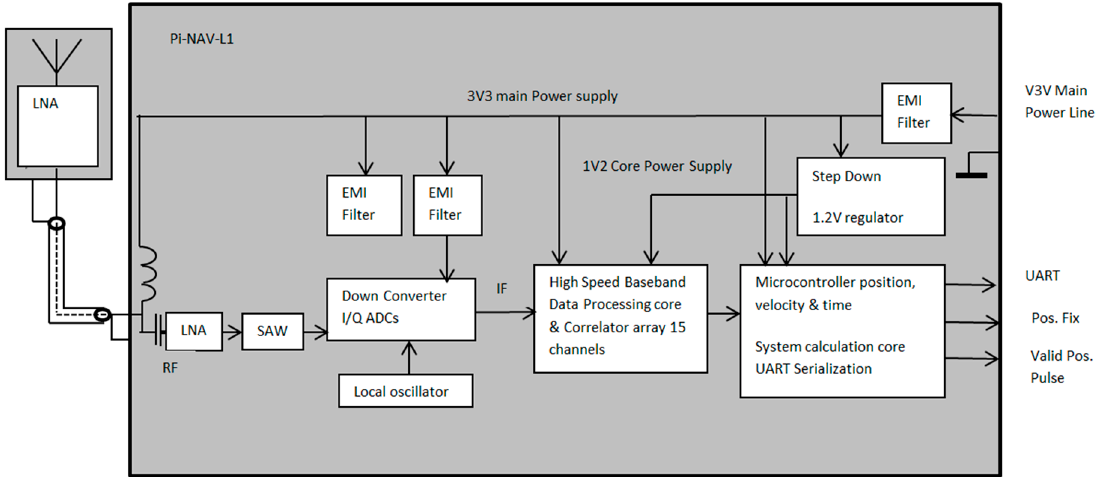
Figure 36. piNAV-L1 Operational Block Diagram [57].